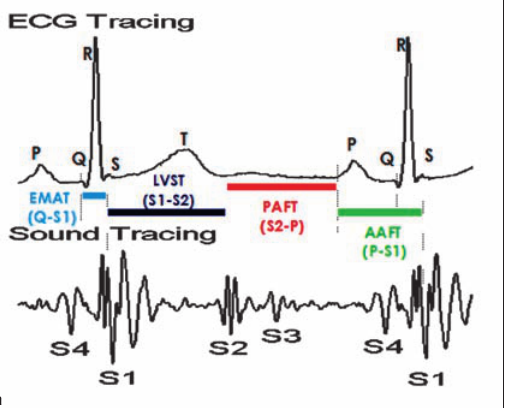
Relationship between ECG and heart sounds. The upper panel (a) presents a schematic of the key landmarks of the ECG and heart sound recordings in the cardiac cycle and the main acoustic car- diographic parame- ters. The lower panel